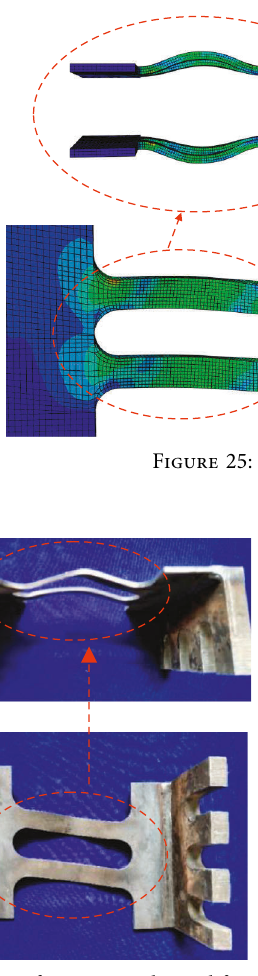
Figure 26: Deformation of RED on the uplift side after the experiment.